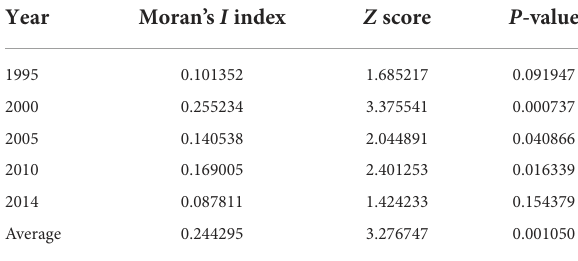
TABLE 3 Global spatial autocorrelation analysis results for myopia prevalence in China from 1995 to